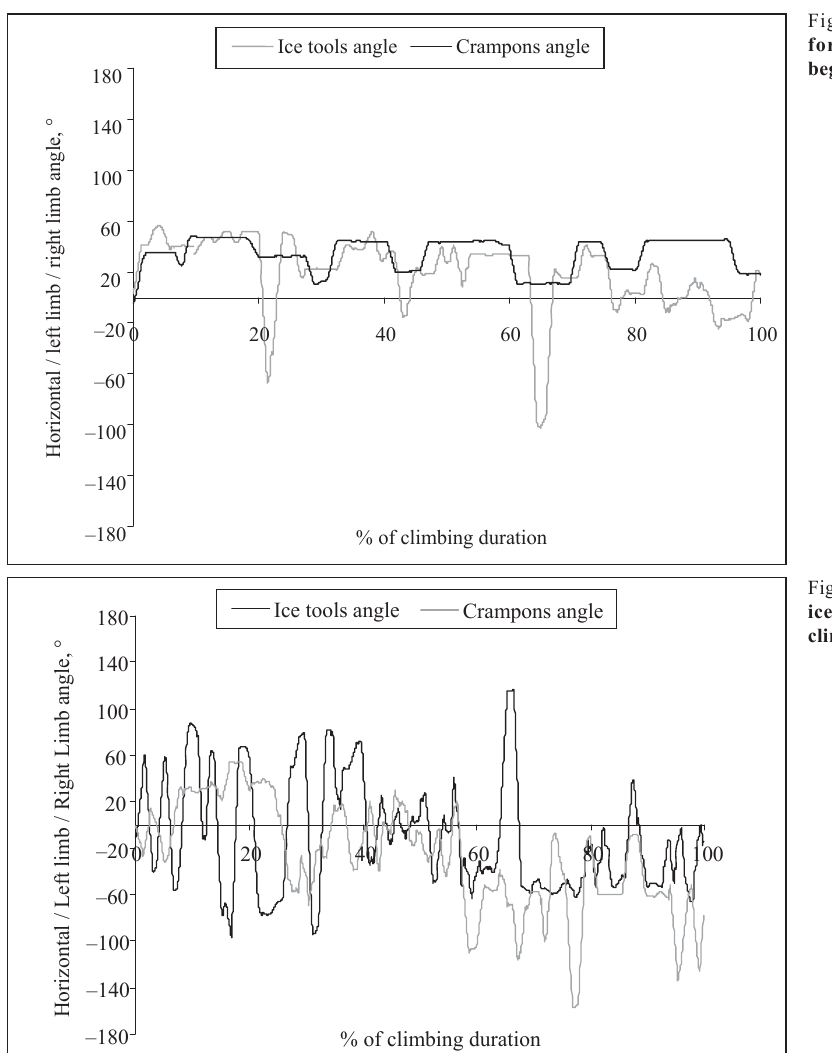
Figure 8. Example of angle-time curve for ice tools and crampons angle of an elite